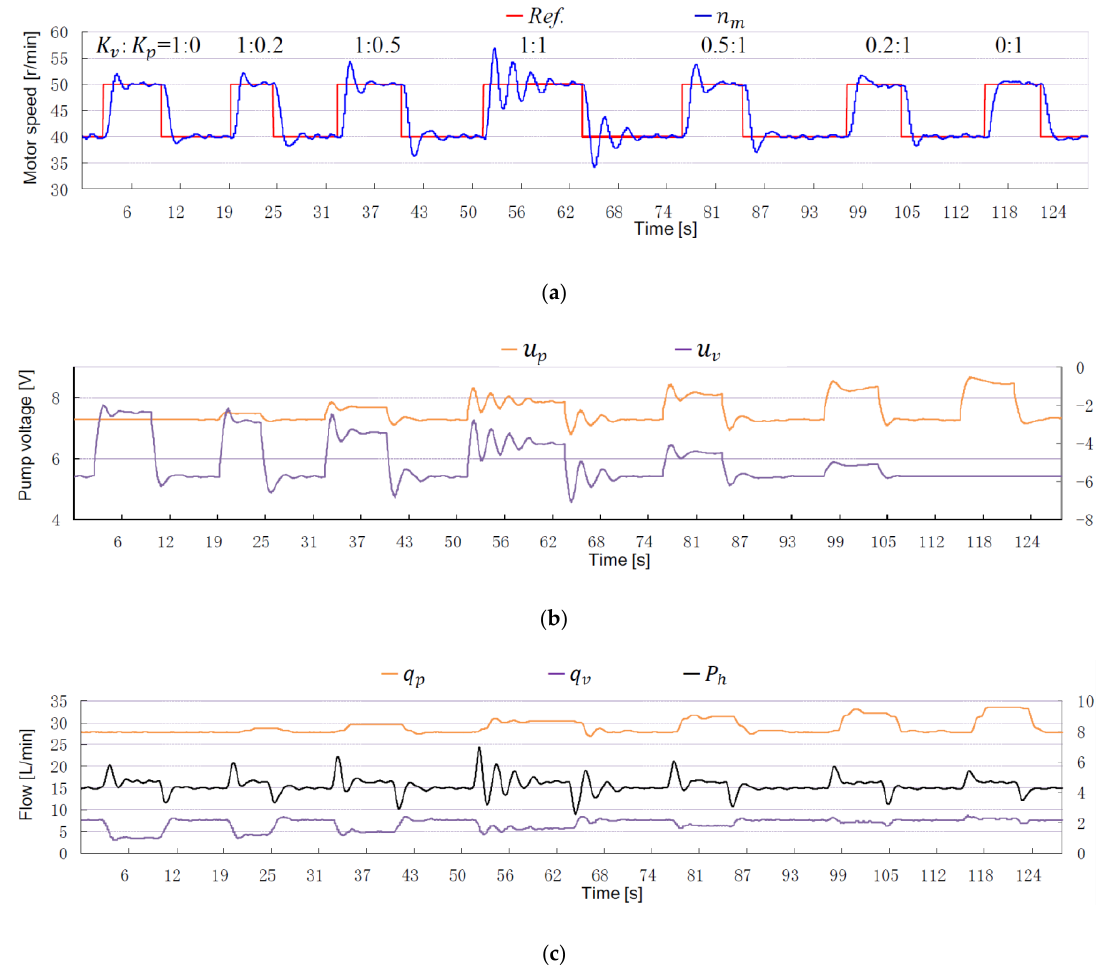
Figure 7. Step response to reference inputs under different weight ratios K vp . ( a ) Motor speed response; ( b ) Pump and valve voltage variation; ( c ) System pressure and flow response.